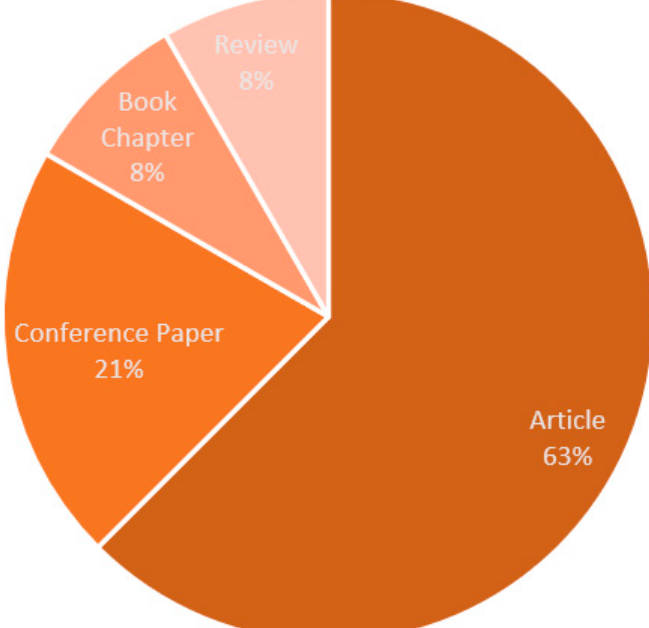
Figure 6. Paper type.